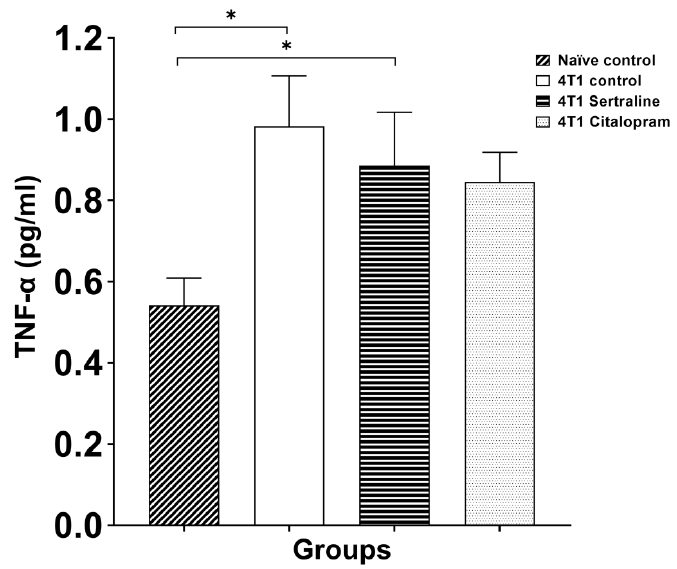
Figure 8. Ex Vivo effects of SSRIs on TNF- α secretion of splenocytes—Splenocytes were derived from the four groups. Splenocytes of SSRI treated 4T1 mice (10 mg/kg/d) were compared to those of 4T1 controls and naïve mice. Ex-vivo TNF- α secretion from splenocytes was measured following LPS stimulation. Each bar represents mean ± SE of three separate experiments ( n = five in each group), expressed as % of controls, as assessed by ELISA following 48 h of incubation. ANOVA revealed p < 0.01 between groups. * p <